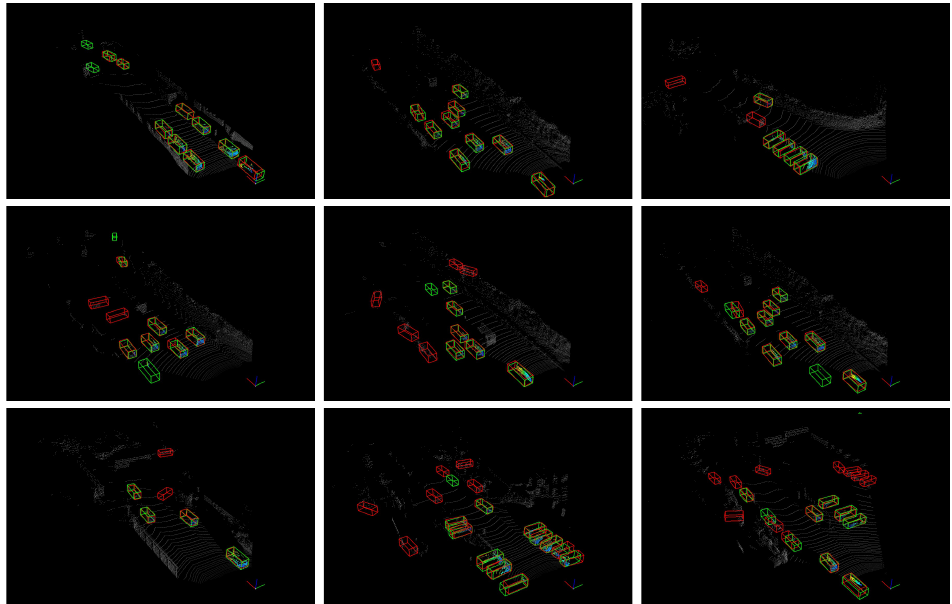
Figure 4. Visualization of the detection results in the KITTI validation set. The ground truth is shown in green bounding boxes. The predictions of our detector are outputs in the red bounding boxes.